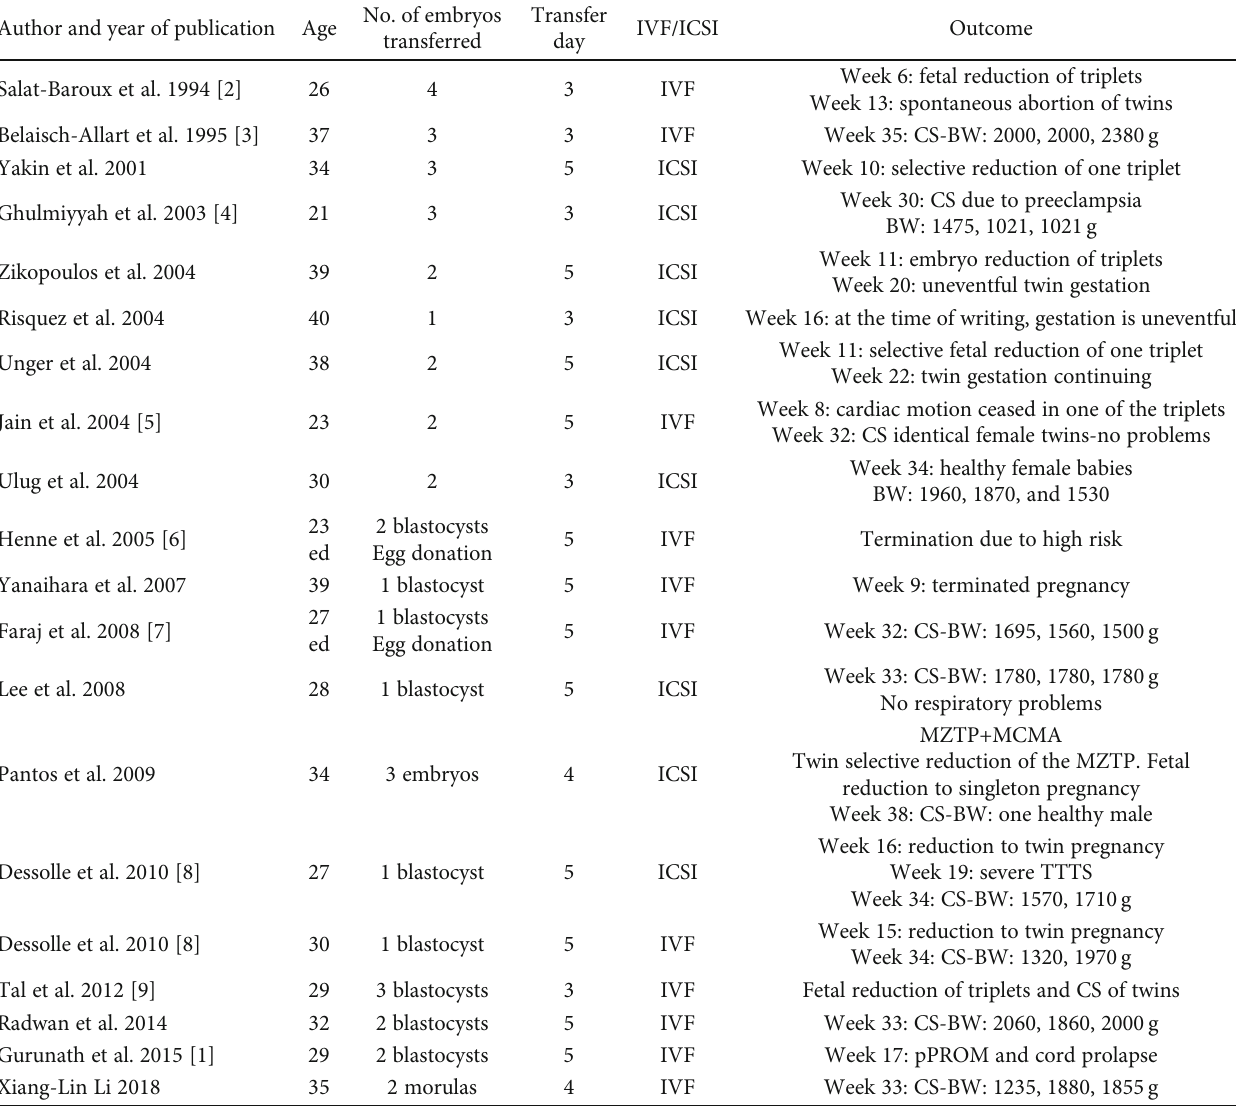
Table 1: Published case reports of MCTA triplets following